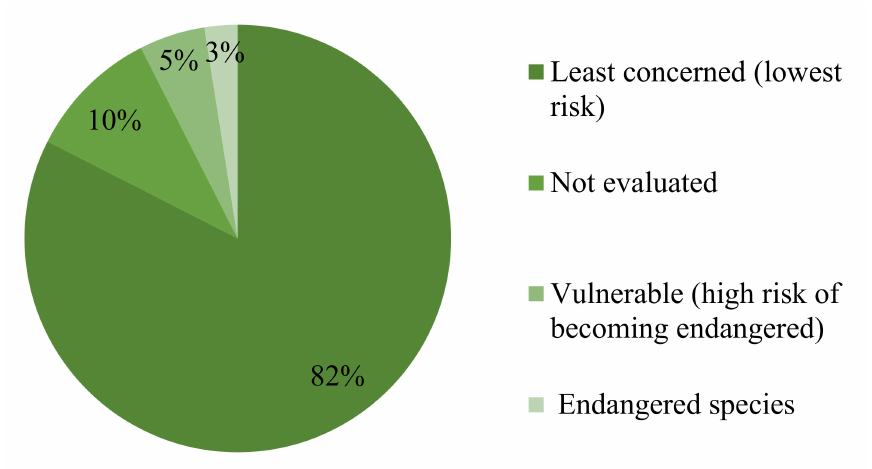
Figure 4. Status of EO-bearing plants in the